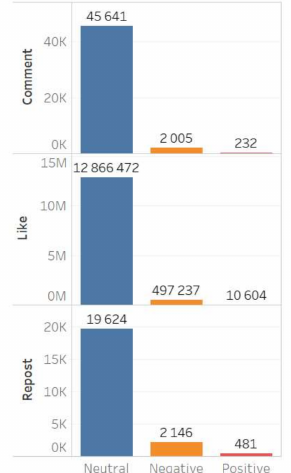
Figure 5. Sentiment of digital footprints of the regional actors’ content.